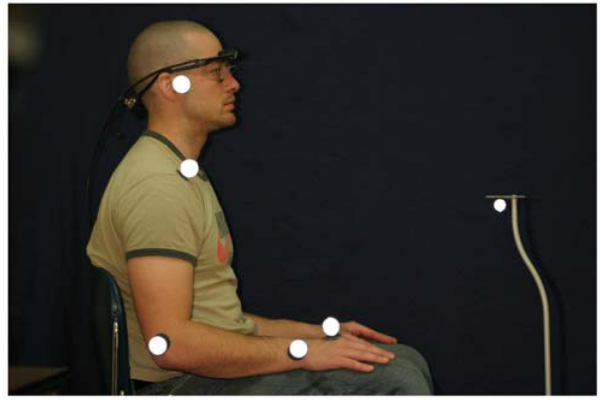
Figure 1. Experimental set-up. The white dots represent light reflective markers on the subject (left) and the food target (right).